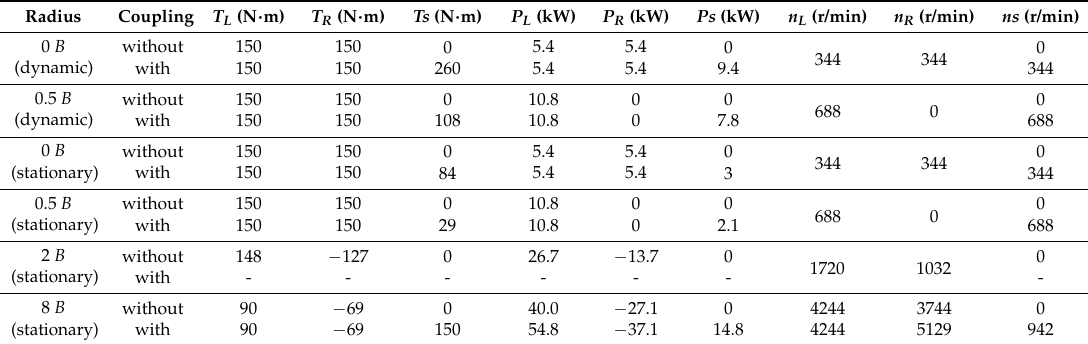
Table 6. Motors’ condition comparison between the vehicle with and without coupling